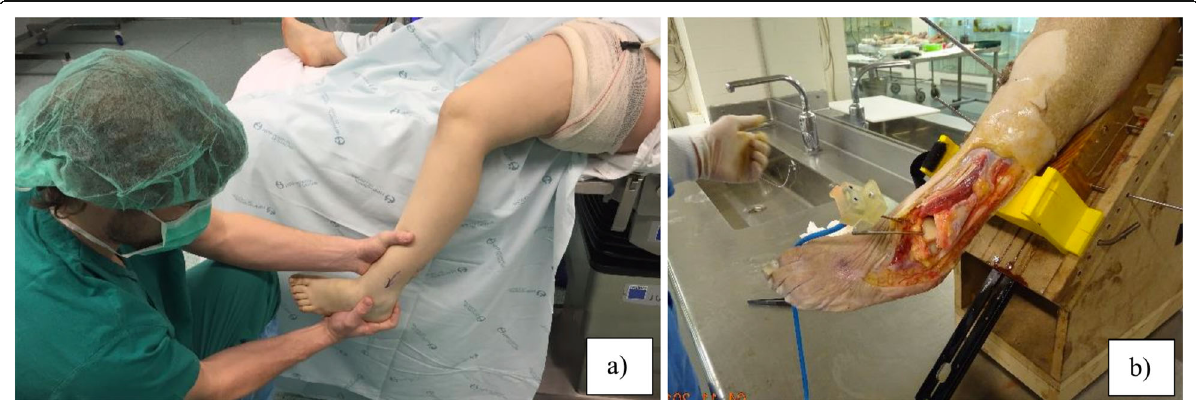
Fig. 6 a Clinical picture of a hanging leg during ankle examination. During this maneuver the leg is oriented 45 degrees in relation to the floor; b Cadaver model after lateral ankle ligaments section (ATFL+CFL+ PTFL). The leg orientation is similar to the clinical objective